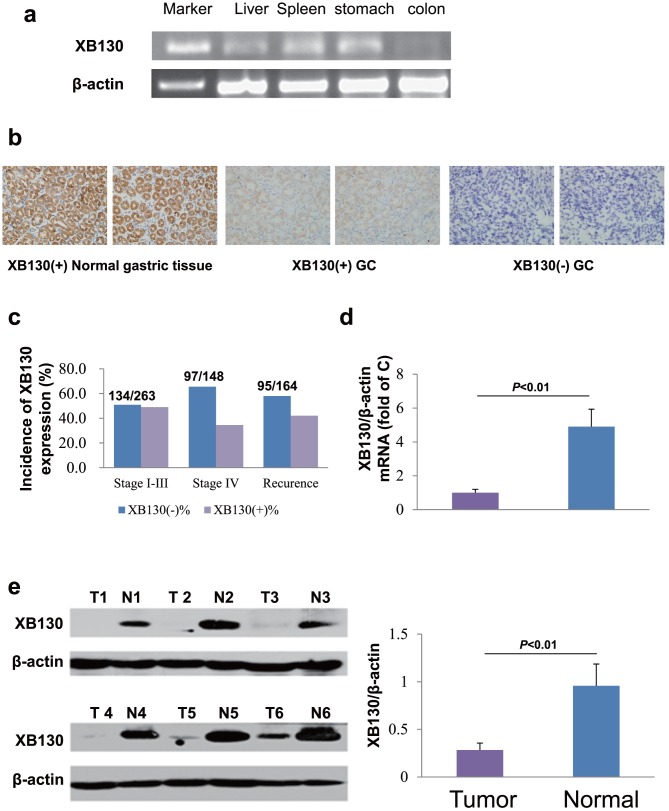
XB130 protein or mRNA expression in gastric tissues.(a) The XB130 gene is expressed in the human liver, spleen, colon and stomach. (b) Representative images of XB130 protein immunostaining in GC tissue and the adjacent non-tumor tissue. (c) Incidence of XB130-negative and XB130-positive GC in stages I–III (n = 263) and stage IV (n = 148). (d) In stage I–III GC after radical resection, XB130 mRNA expression was significantly lower in tumor tissue than in the corresponding adjacent non-tumor tissue quantified by fluorescence PCR (p<0.01, n = 9 per group). (e) Expression of XB130 protein by stage I–III GC (T) is significantly reduced compared with that by normal gastric tissue (N) on western blotting (p<0.01, n = 6 per group). Samples in (a), (d) and (e) were fresh tissues from patients with stage I–III GC who received radical resection surgery, while samples in (b) and (c) were from patients with stage I–IV GC as described in the method section.